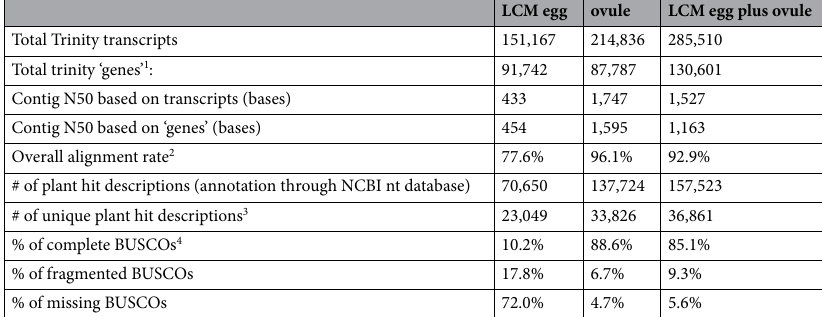
LCM egg assembly LCM egg plus ovule assembly